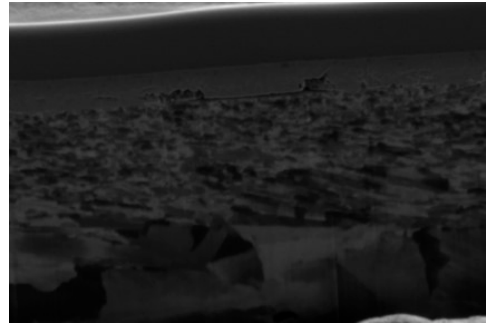
Figure 4. Cross-section SEM image of untested SS 316L sample, (20,000×).